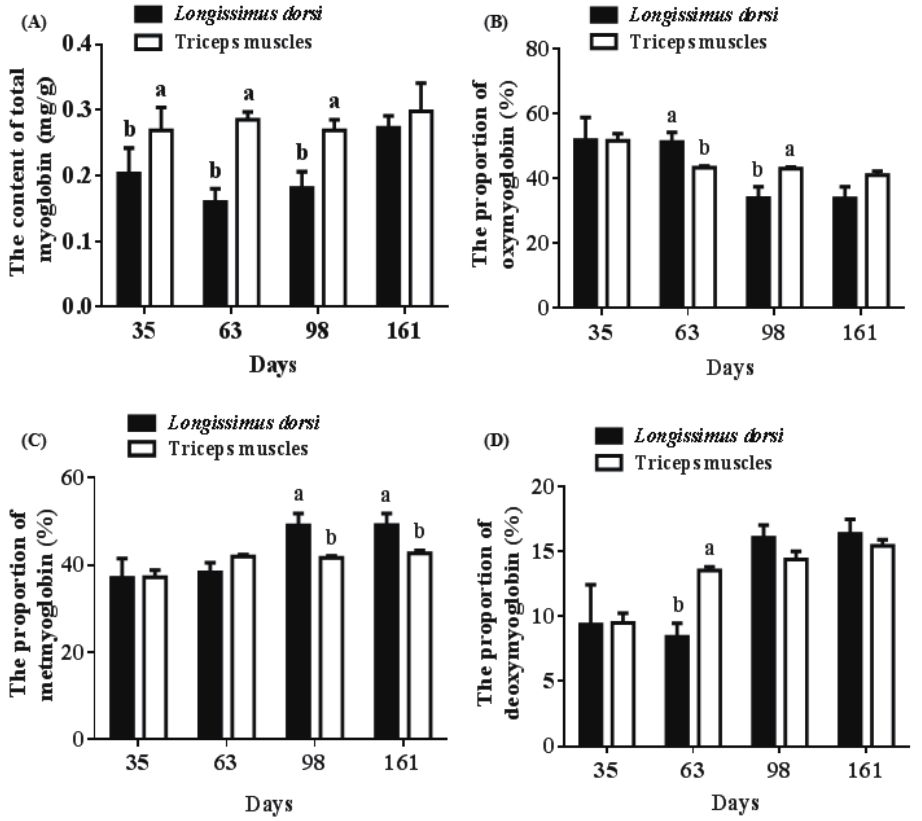
Figure 5. Different muscle profiles of porcine myoglobin. (A) Differences in total myoglobin content between longissimus dorsi and the triceps muscles. (B) Differences in oxymyoglobin content between longissimus dorsi and triceps muscles. (C) Differences in metmyoglobin content between longissimus dorsi and triceps muscles. (D) Differences in deoxymyoglobin content between longissimus dorsi and the triceps muscles. Mean with different superscripts demonstrate significant difference among groups (p<0.05), n =